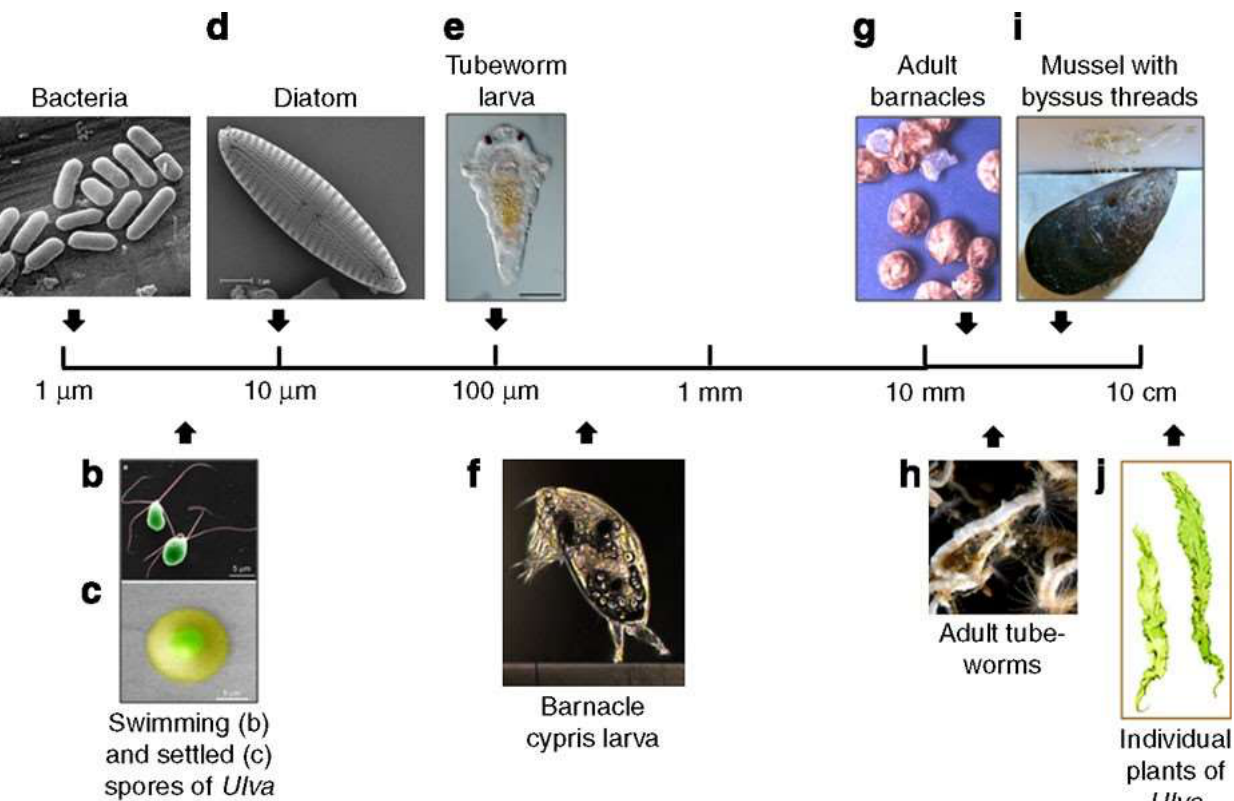
Figure 2. Common marine fouling organisms. Reprinted with permission from Ref. [10]. Copy- right 2011 Springer Nature.